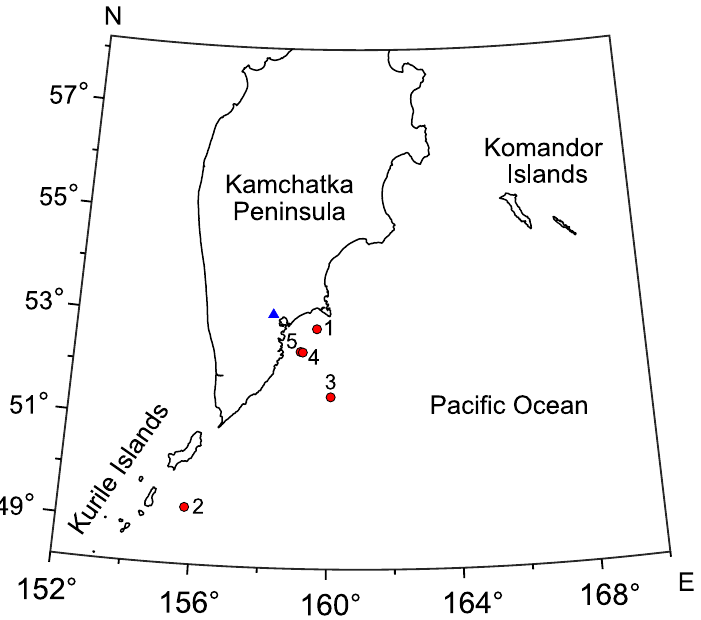
Figure 5. Kamchatka peninsula map with locations of epicenters of earthquakes considered in the paper. Blue triangle ( (cid:78) ) indicates Mikizha lake, red circles ( • ) are earthquake epicenters. Table 1. Earthquake